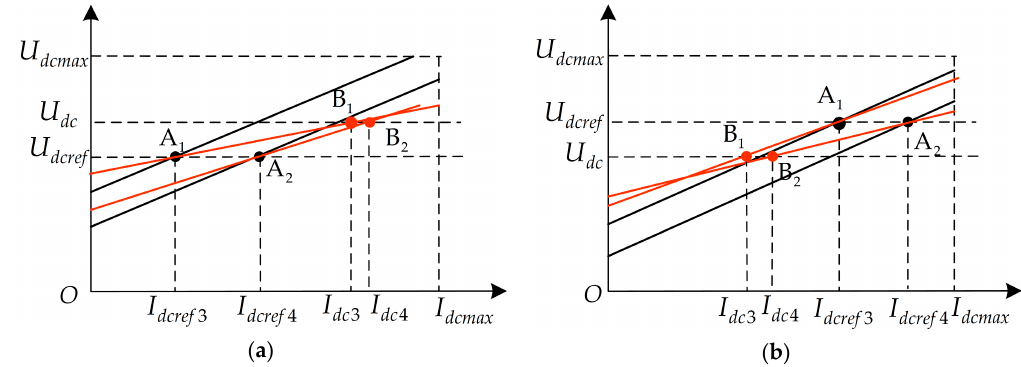
Figure 9. The adjustment curve of the adaptive droop coefficient: ( a ) The DC current increases; ( b ) the DC current decreases.